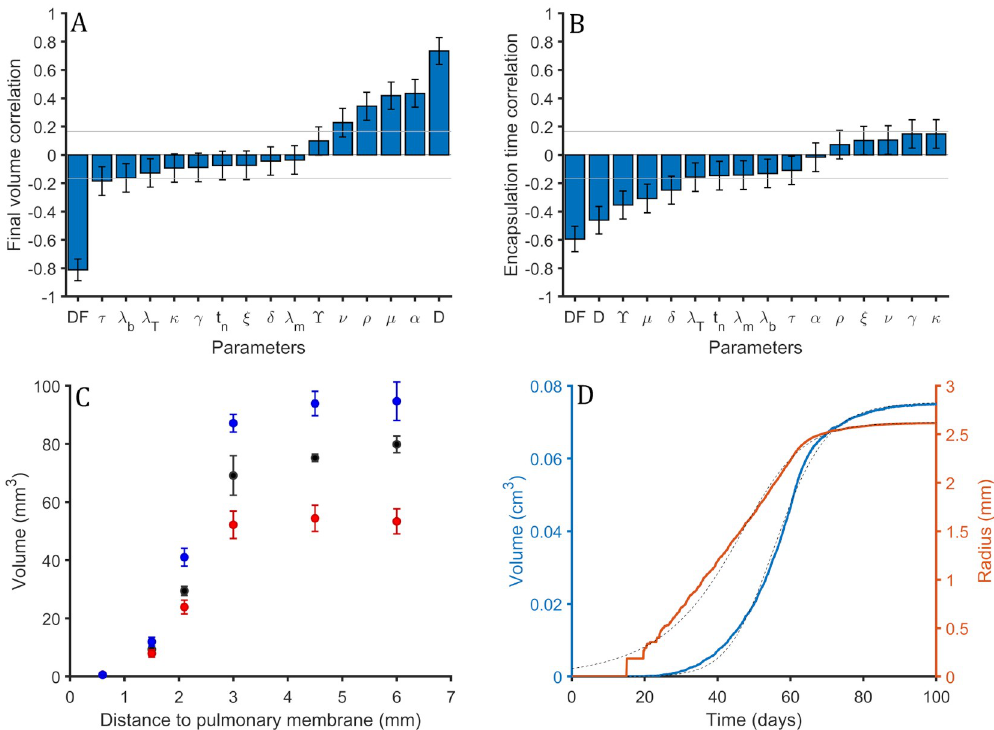
Fig 7. Sensitivity analysis of 3D model. (A) Partial Rank Correlation Coefficient (PRCC) values between volume of the final lesion and explored input parameters of the model. 100 sets of input parameters are used. Gray horizontal lines are marked at ± 0.166 to mark the significance threshold for PRCC values using a significance level of 0.05. Error bars are computed as the standard error of Spearman’s correlation coefficient. (B) PRCC values between encapsulation time and input parameters. 100 sets of input parameters are used. Gray horizontal lines are marked at ± 0.165 to mark the significance threshold for PRCC values using a significance level of 0.05. Error bars are computed as the standard error of Spearman’s correlation coefficient. (C) Distance to the nearest pleura against the volume of the resulting lesion. Each point is the mean value and standard deviation for three different simulations. Different values of D are explored. In black, baseline value, in red, baseline value divided by 2 and, in blue, baseline value multiplied by 2. (D) Volume, in blue, and radius, in orange, of the lesion using baseline values. Dotted black line is generalized logistic second degree curve approximation defined by Eqs